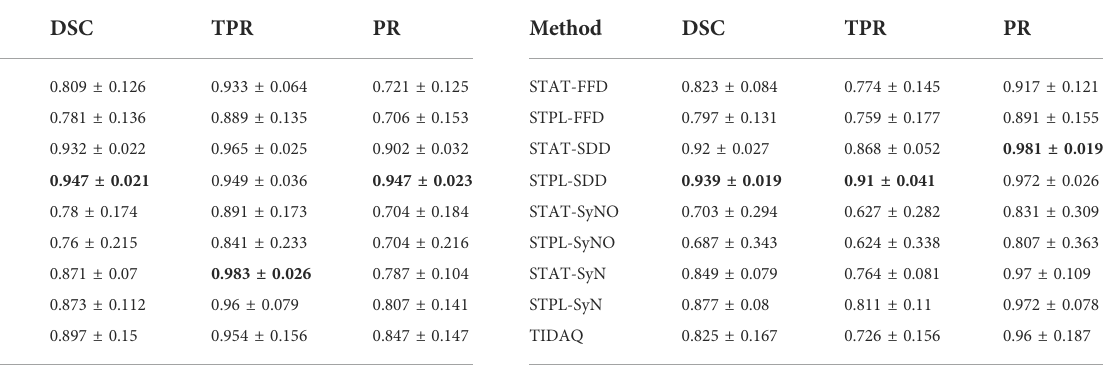
TABLE 5 38% Trabecular Bone Segmentation Performance (mean ± standard deviation). DSC: Dice Similarity Coef fi cient, TPR: True Positive Rate, PR: